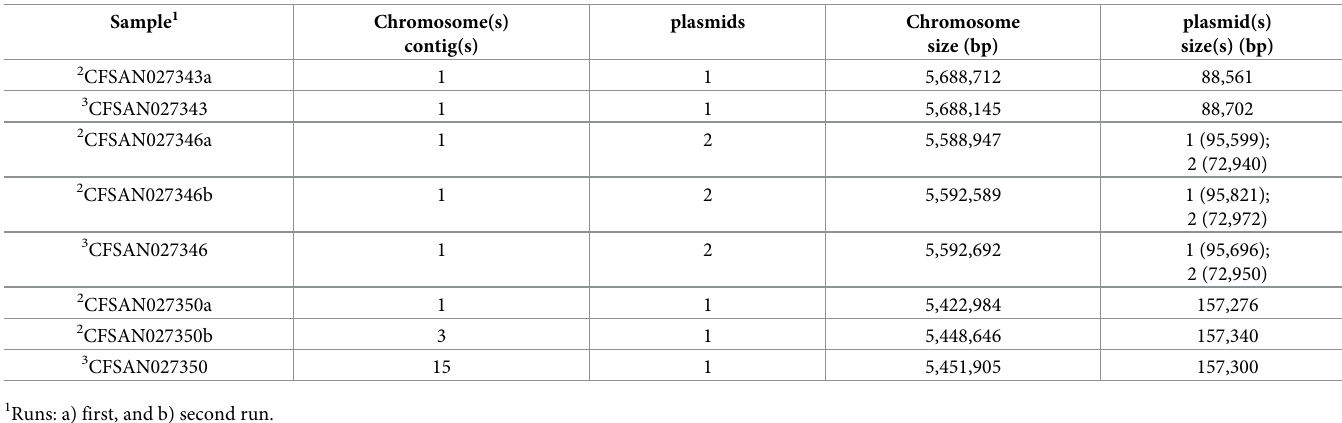
Table 4. Assembly statistics MinION.